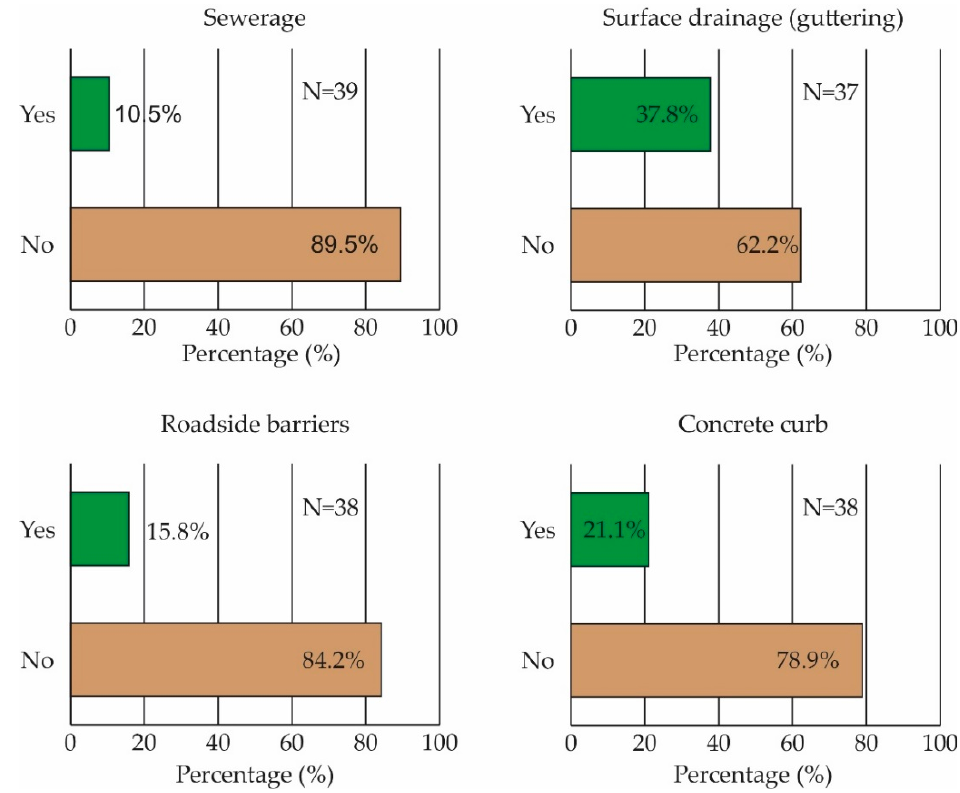
Figure 6. Distribution of cases with respect to road